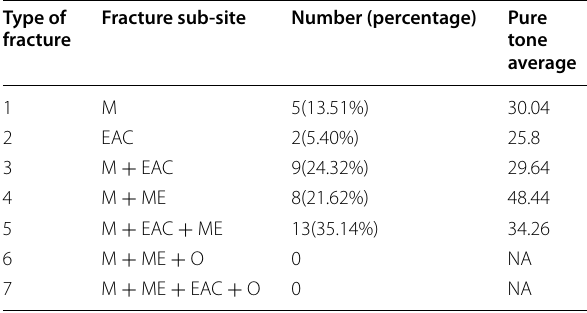
Table 2 The type, sub-site fracture classification, number